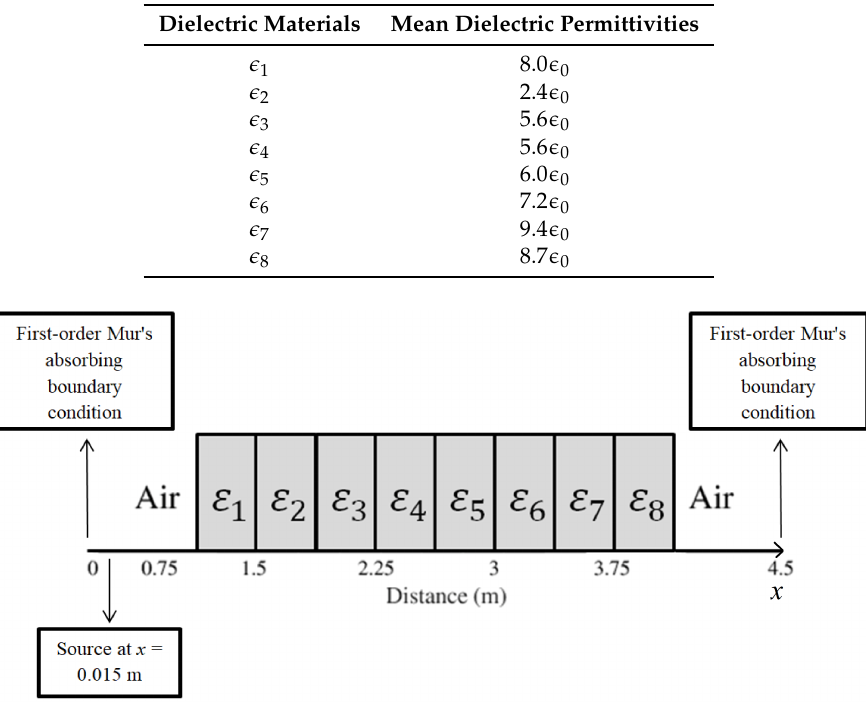
Figure 1. Geometric features of the 1D transmission-line